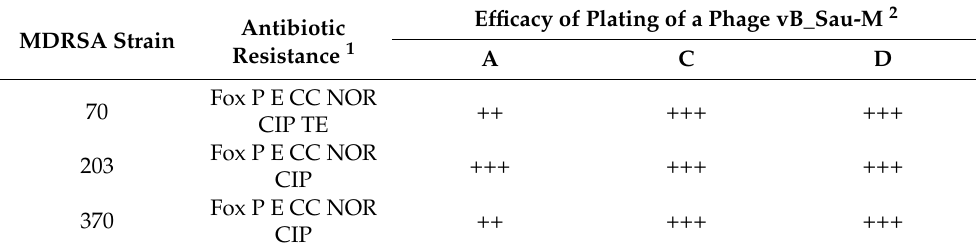
Table 1. Antibiotic resistance and efficacy of plating of phages vB_SauM-A, vB_SauM-C and vB_SauM-D of MDRSA strains 70, 203 and